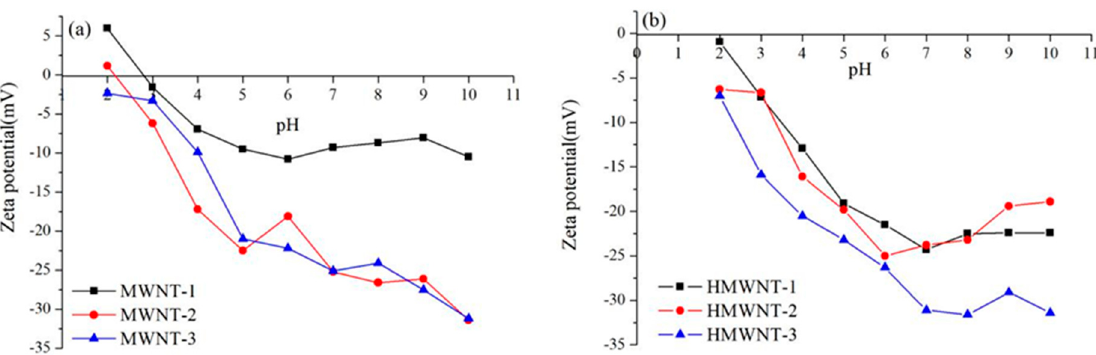
Figure 2. Effect of pH on the surface charge property and density of MWNTs ( a ) and HMWNTs ( b ).